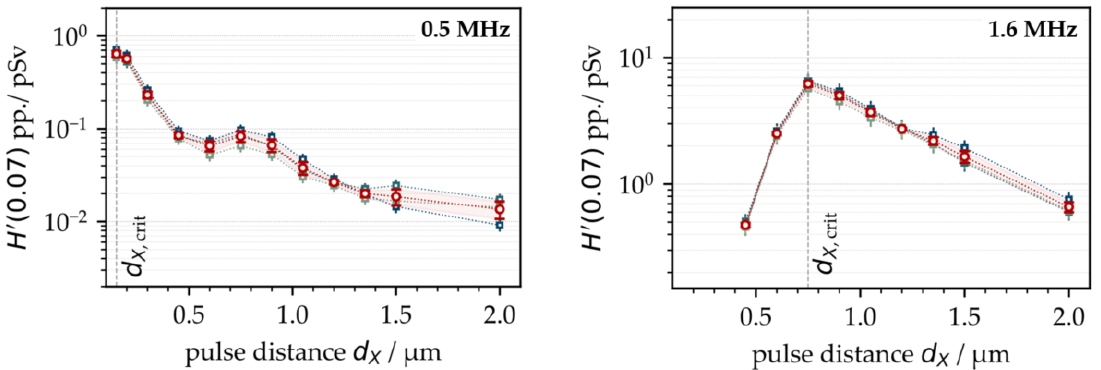
Figure 5. X-ray emission dose per pulse as a function of the intra-line pulse distance at 0.5 MHz ( left ) and 1.6 MHz ( right ) PRF obtained on 2 different days under controlled suction flow conditions. The suction flow speed was kept constant at 0.9 m/s ± 0.3 m/s. The mean values are highlighted by the red symbols (circles). The critical intra-line pulse distances d X,crit are indicated.